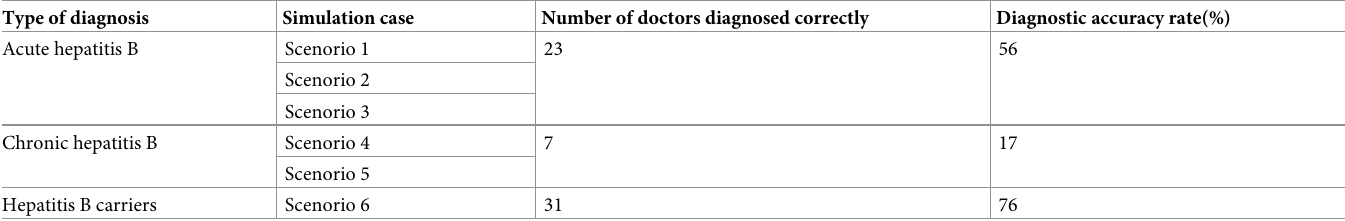
Table 3. Knowledge of the diagnostic criteria of hepatitis B among 41 clinicians in Gannan prefecture of Gansu province in 2017. Type of